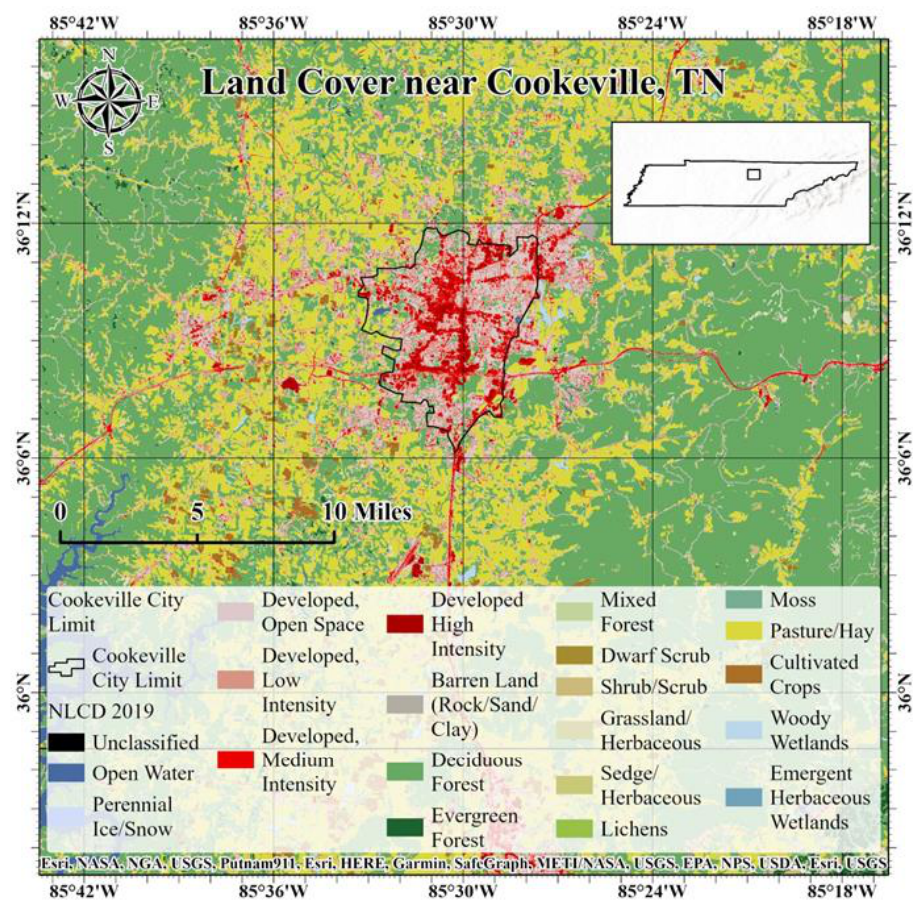
Figure 1. ( A ) Map showing the location of the measurement site (36.1628 ◦ N, 85.5016 ◦ W) and surroundings of the city of Cookeville with the neighboring counties and major highways. A detailed description of Cookeville can be found in the main text. ( B ) GIS land cover map showing detailed broadleaf and deciduous trees and shrubs for the region surrounding the Cookeville urban domain. The data used to construct the map were initially obtained from the Land Cover Database (NLCD) 2019 Products (ver. 2.0, June 2021)